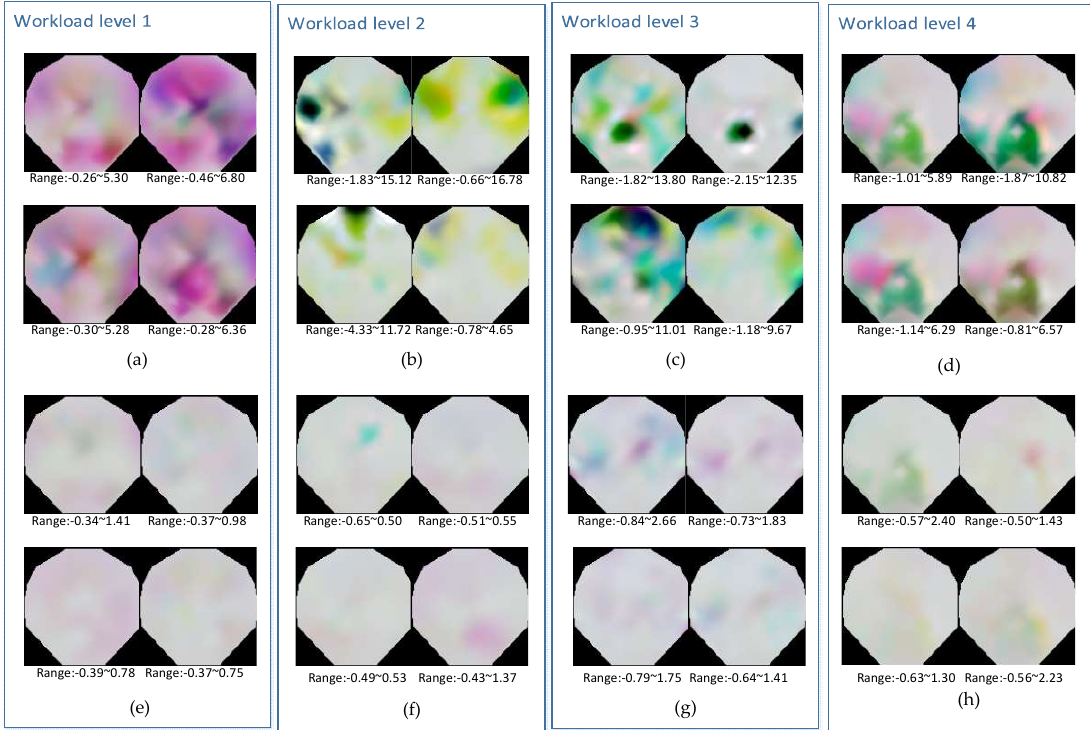
Figure 3. Visualization of examples from four different workload levels. ( a – d ) show some samples of maps with obvious features in four classes and the range of spectral value are given. ( e – h ) show some samples of maps with unobvious features in four classes and the range of spectral value are given. All these values have been subtracted from the average spectral value of the whole dataset.